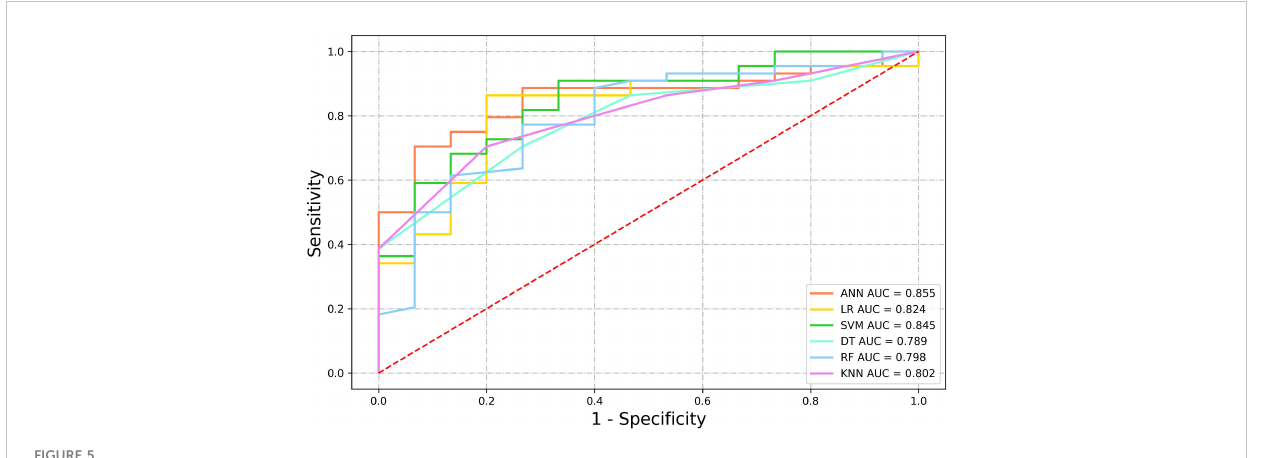
FIGURE 5 ROC curves of six machine learning